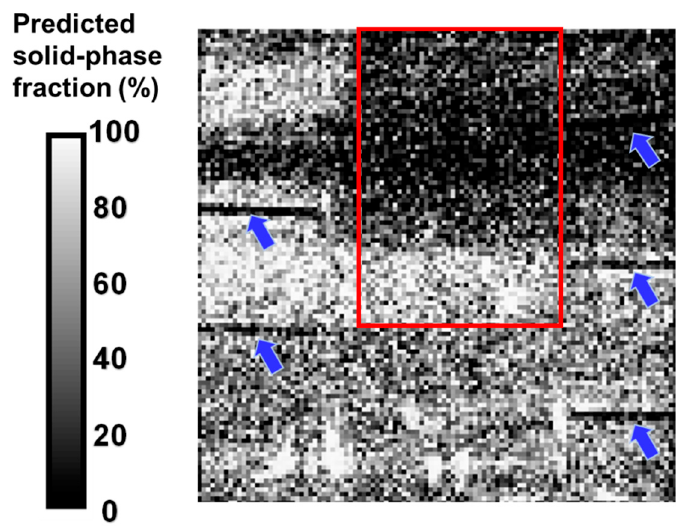
Figure 13. An example of solid–liquid phase fraction imaging (80 mm × 80 mm) results obtained by ML analysis (at the beginning of the solidification process). The black shadows at the blue arrow positions in the figure are the thermocouples in the sample. To eliminate the influence of the thermocouples and the insulation material around the sample container, the data inside the red frame were used for the analysis to determine the movement of the solid–liquid interface.